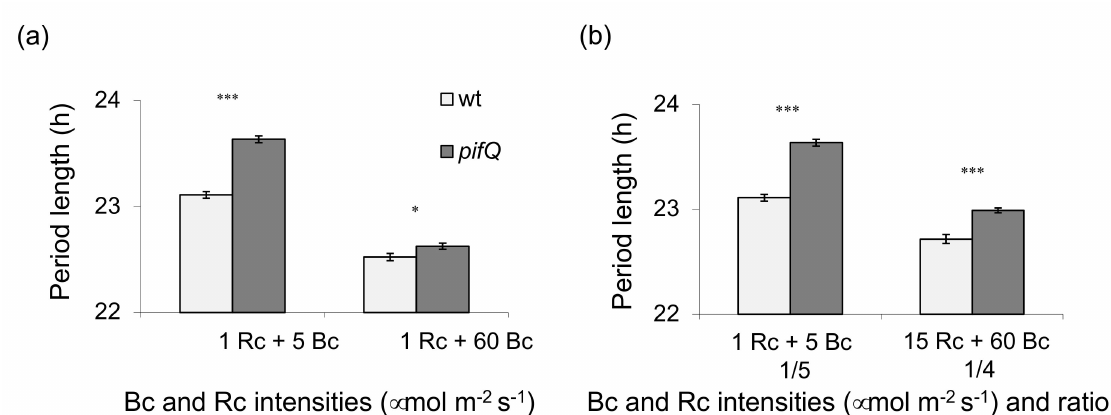
Figure 3. The red/blue light ratio is important for PIF regulation of the circadian oscillator. pifQ CCA1:LUC and wt CCA1:LUC plants were entrained for 8 days in 14 h: 10 h white light: dark (white light, 100 µ mol m − 2 s − 1 ) on medium supplemented with 3% sucrose before being transferred to different constant light conditions and luciferase activity measured. ( a ) Similar Rc light intensity and varied Rc/Bc ratio. ( b ) Similar Rc/Bc ratios and varied total light intensity. Average of 4 biological repeats. n ≥ 213. * p < 0.05, *** p < 0.001 (Student two-tailed t